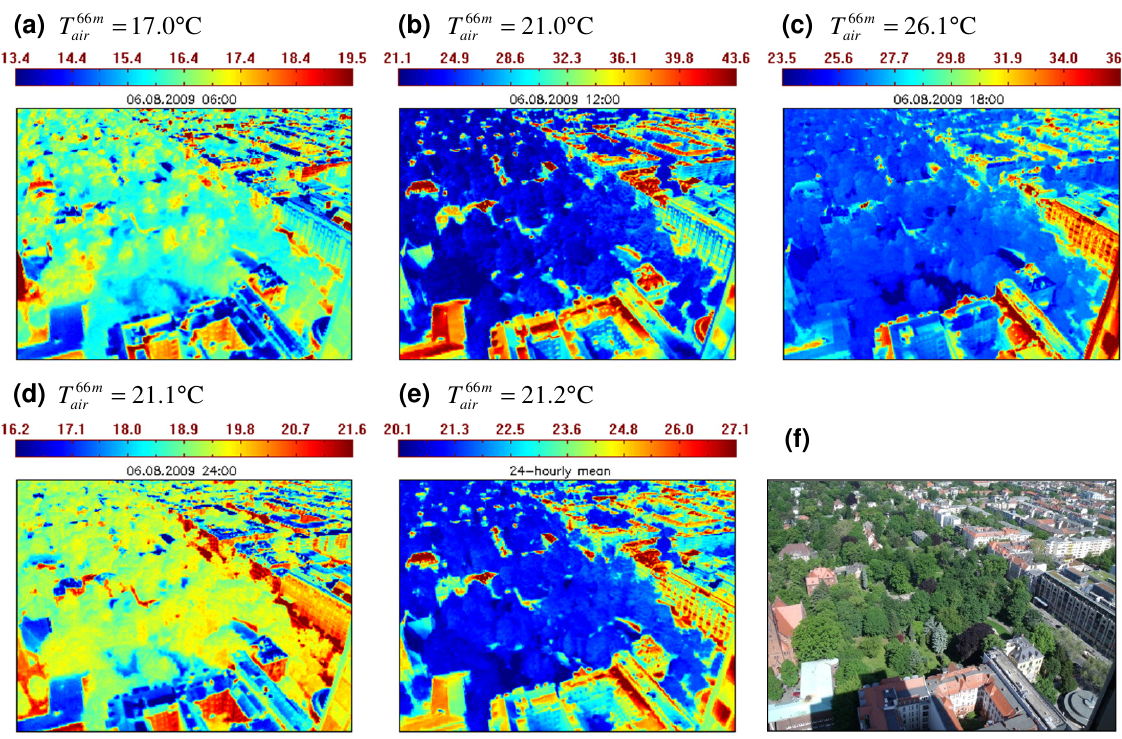
Fig. 6. Atmospherically corrected TIR imagery using the MLOS method for selected 30-min periods during 6 August 2009 at (a) 06:00, (b) 12:00, (c) 18:00 and (d) 24:00CET, (e) the 24-hourly mean pattern and (f) a photograph showing the FOV of TIR camera.